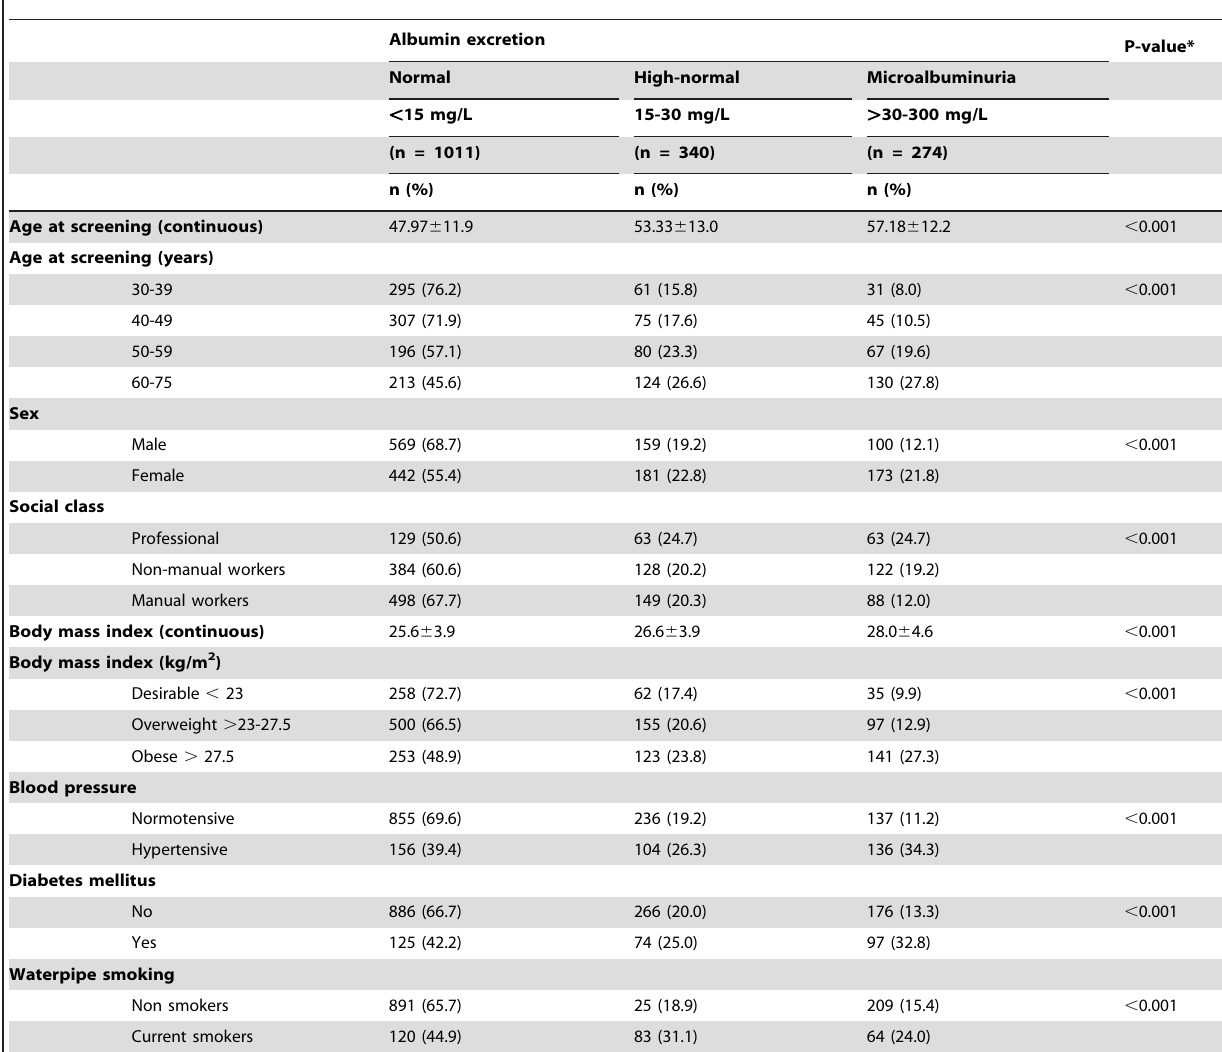
Table 1. Baseline characteristics of study participants by albumin